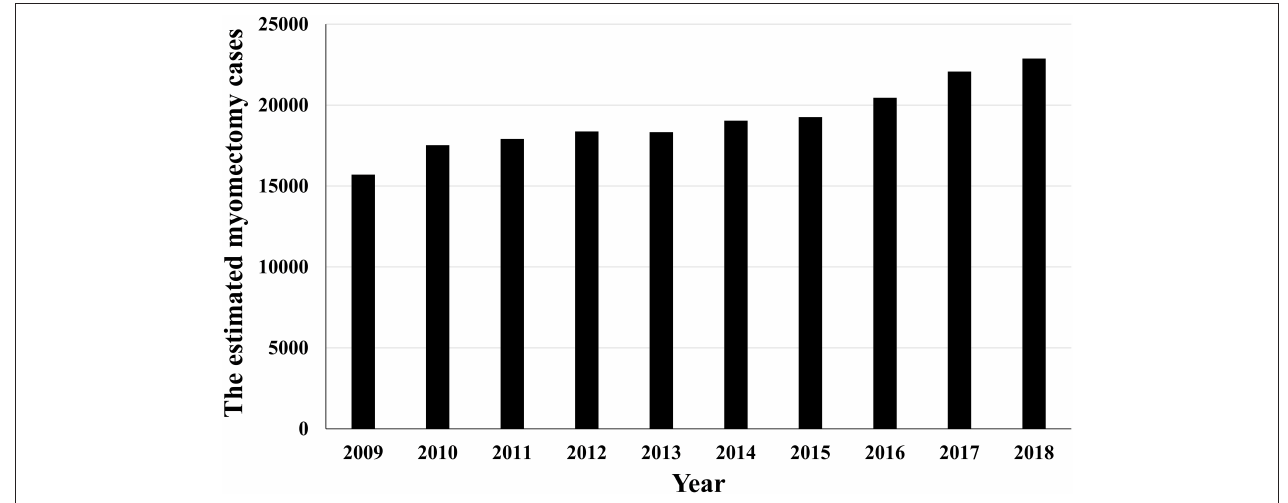
FIGURE 2 | The estimated number of myomectomy cases in different years from the HIRA-NISHIRA-NIS database.